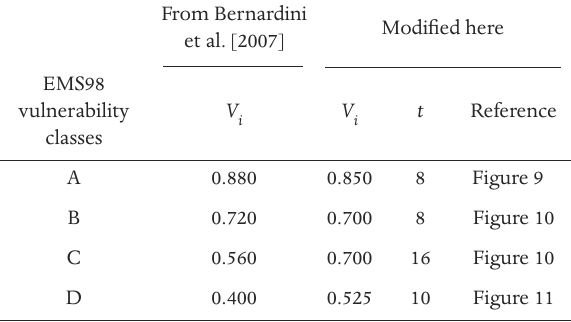
Table 2. EMS98 vulnerability classes and RISK-UE vulnerability in- dexes V used for the “blind” scenario [Bernardini et al. 2007] ( t = 6 i was used for all classes) and the modified V cording to observations of Rossetto et al. [2009], Liel and Linch [2009] and Tertulliani et al. [2010].